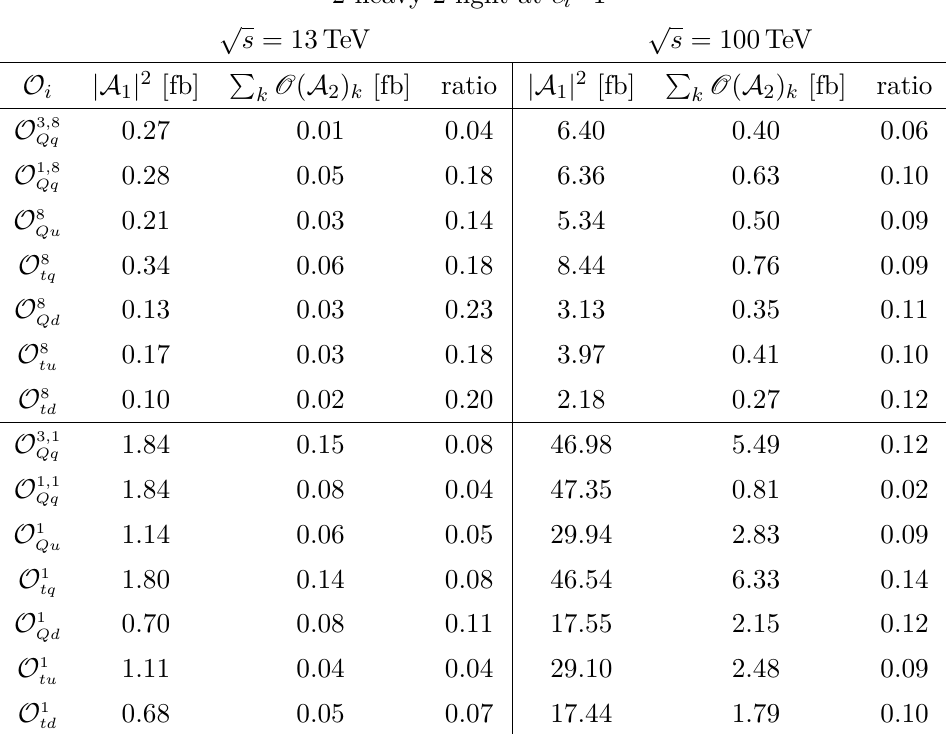
Table 4 . Cross-section predictions from the diagonal squared single-insertion contributions at O (Λ − 4 ) are denoted by |A 2 and compared to the sum of all double-insertion contributions, O ( A 1 | up to O (Λ − 8 ) . The ratio column is that of double-insertion contributions to squared single-insertion ones. The results are presented for the LHC and FCC-hh collider